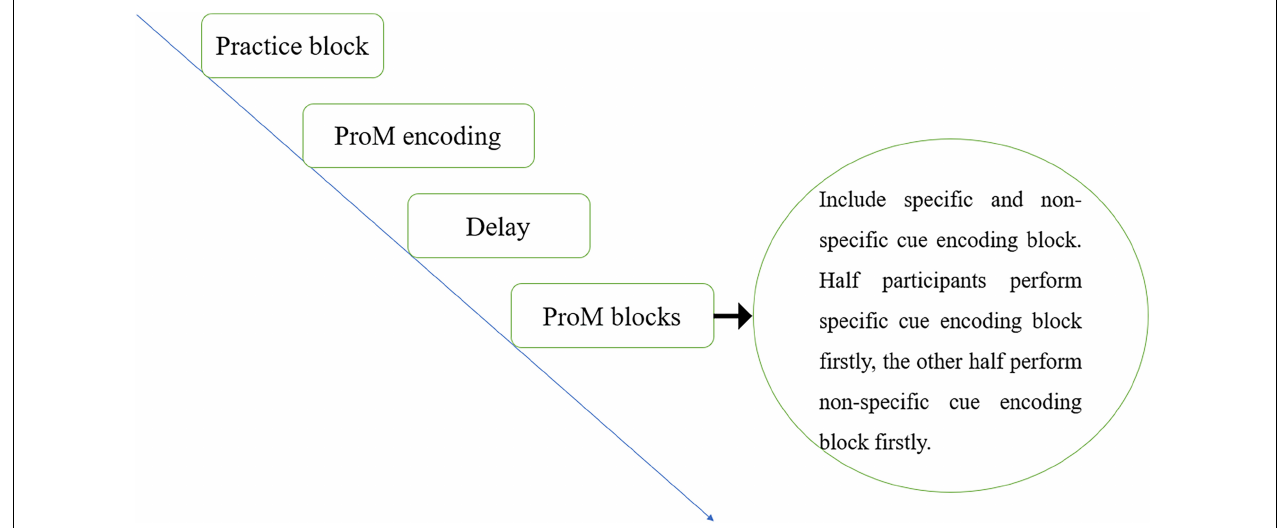
FIGURE 1 | The procedure for Experiment